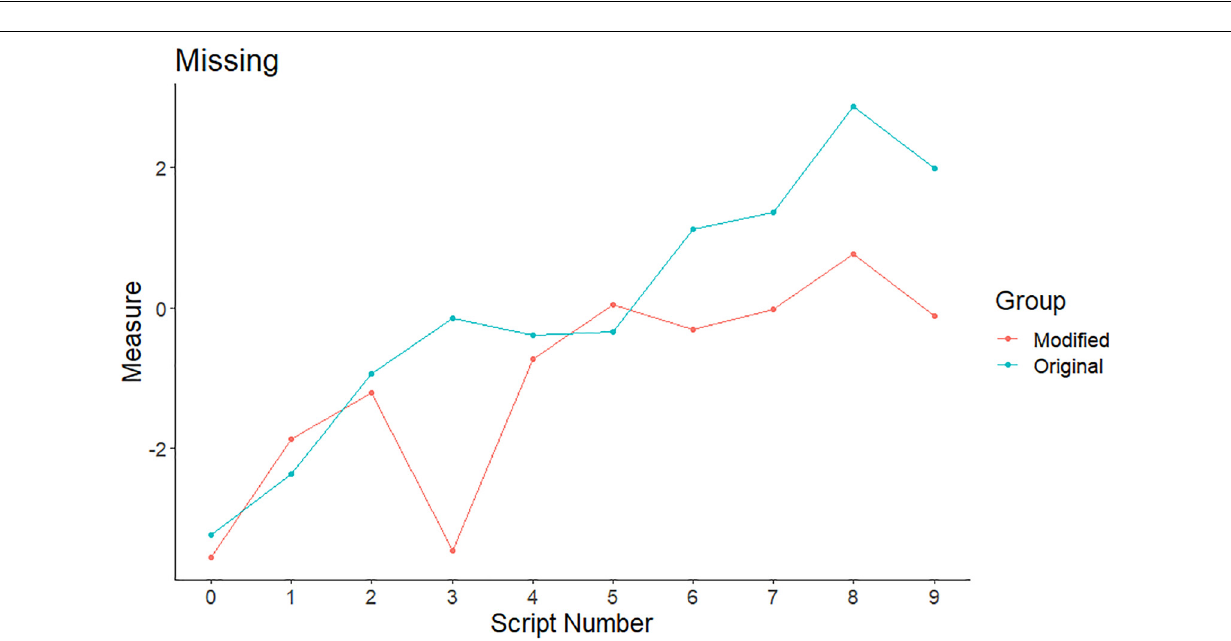
FIGURE 4 | CJ measures for the original and modified script variants: spelling, punctuation, and grammar (SpaG).